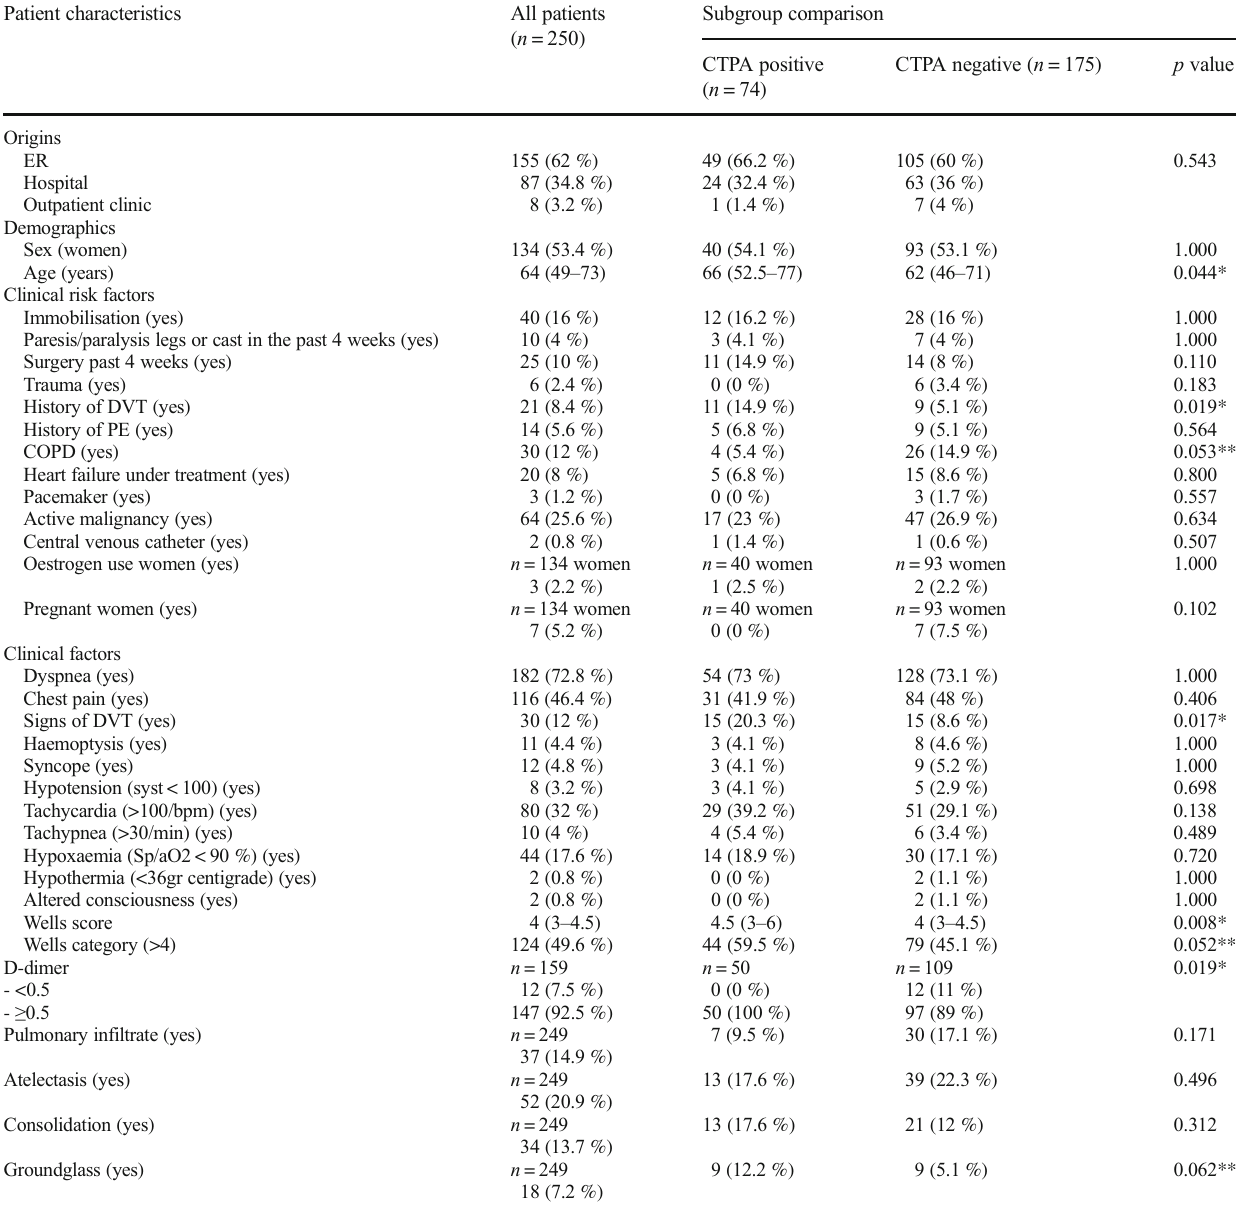
Patient characteristics and subgroup comparison of patients with a positive CTPA versus a negative CTPA scan Patient